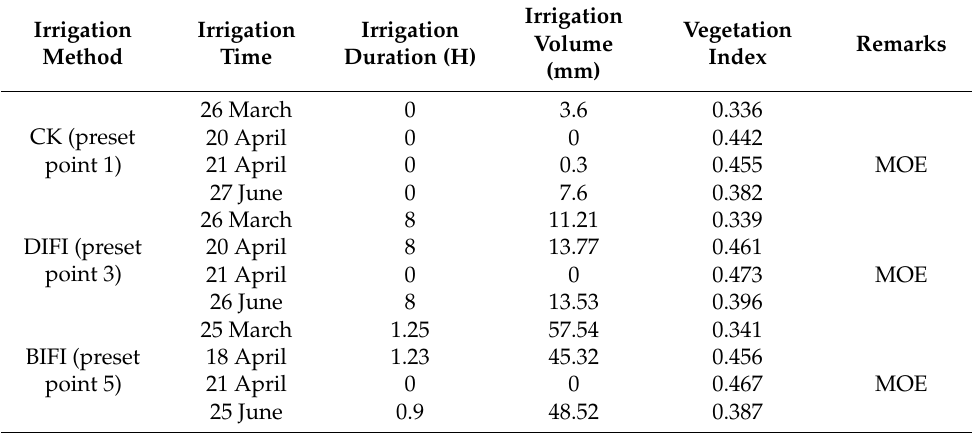
Table 3. The difference in values like amplitude and change at some critical